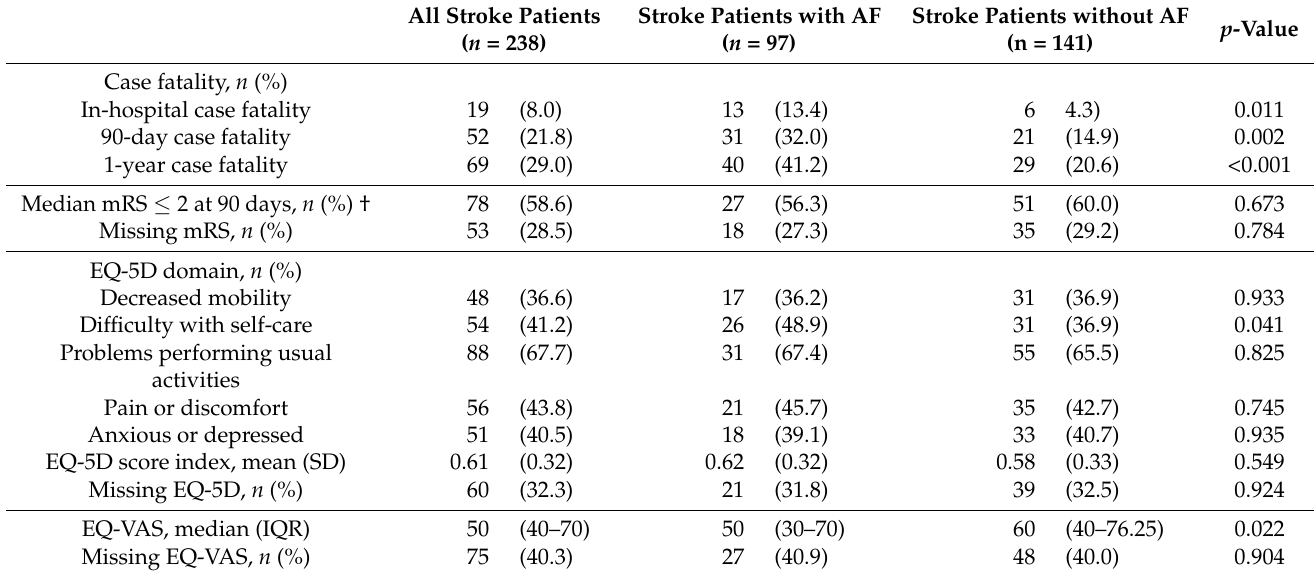
Table 3. Case fatality, functional outcome, and health-related quality of life of stroke patients with and without atrial fibrillation at 90 days.